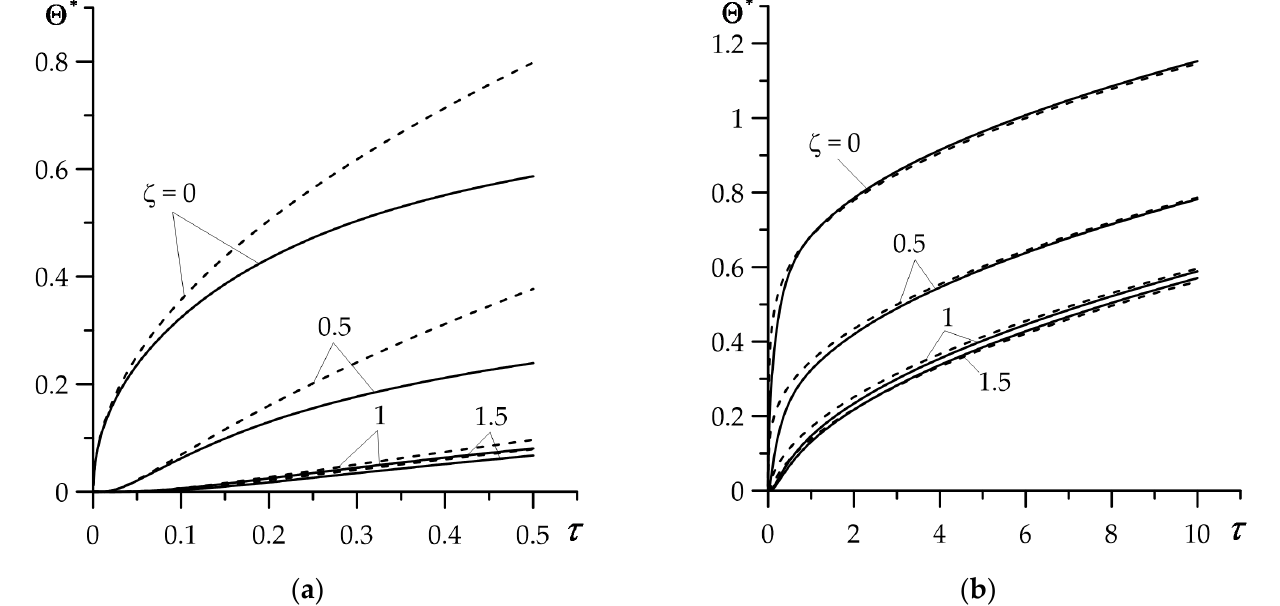
Figure 4. Comparison of time profiles of dimensionless temperature rise Θ ∗ ( ζ , τ ) in the FGC, obtained using the exact (68), (69) (solid lines) and asymptotic (dashed lines) solutions: ( a ) for small (76), (77), ( b ) for large (80), (81) Fourier number τ , for selected values of dimensionless spatial variable ζ .